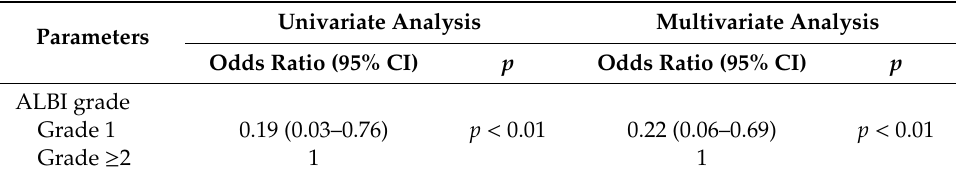
Table 5. Univariate and multivariate logistic regression analysis for factors a ff ecting the treatment discontinuation due to